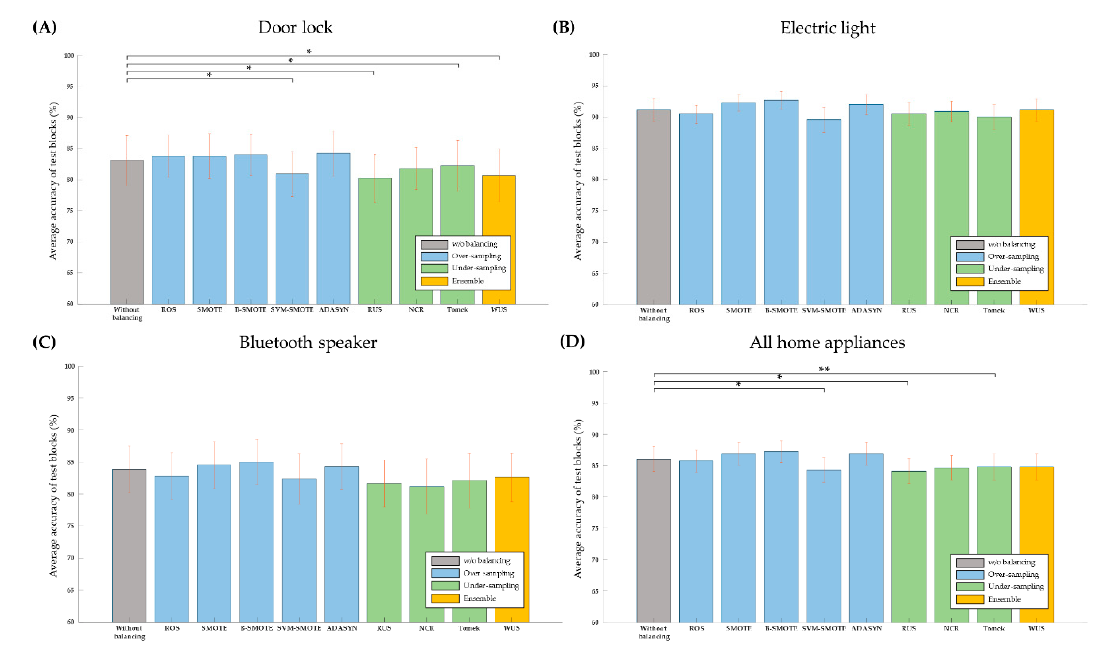
Figure 3. Average accuracy of controlling each home appliance using P300-based BCIs without balancing as well as various over-, and undersampling techniques for balancing. See the text for details. Accuracy for controlling for each home appliance as well as total accuracy is shown: ( A ) door lock, ( B ) electric light, ( C ) Bluetooth speaker, and ( D ) sum of them. Red vertical bars denote standard error of mean and * marks denote statistical significance ( p < 0.05), and ** mark denote statistical significance ( p < 0.005).